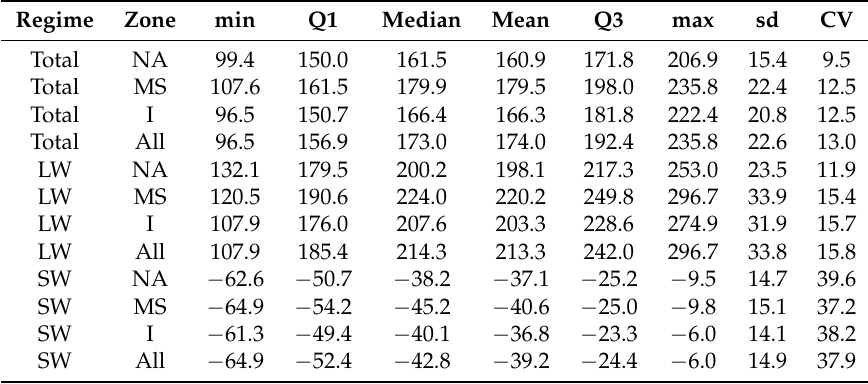
Table 2. Summary statistics of WVRE. All values are in W m − 2 , except CV (in %). The table shows the minimum (min), the first quartile (Q1), the median, the mean, the third quartile (Q3), the maximum (max), the standard deviation (sd) and the coefficient of variation (CV). The zones are: North Atlantic (NA), Mediterranean Sea (MS) and Interior